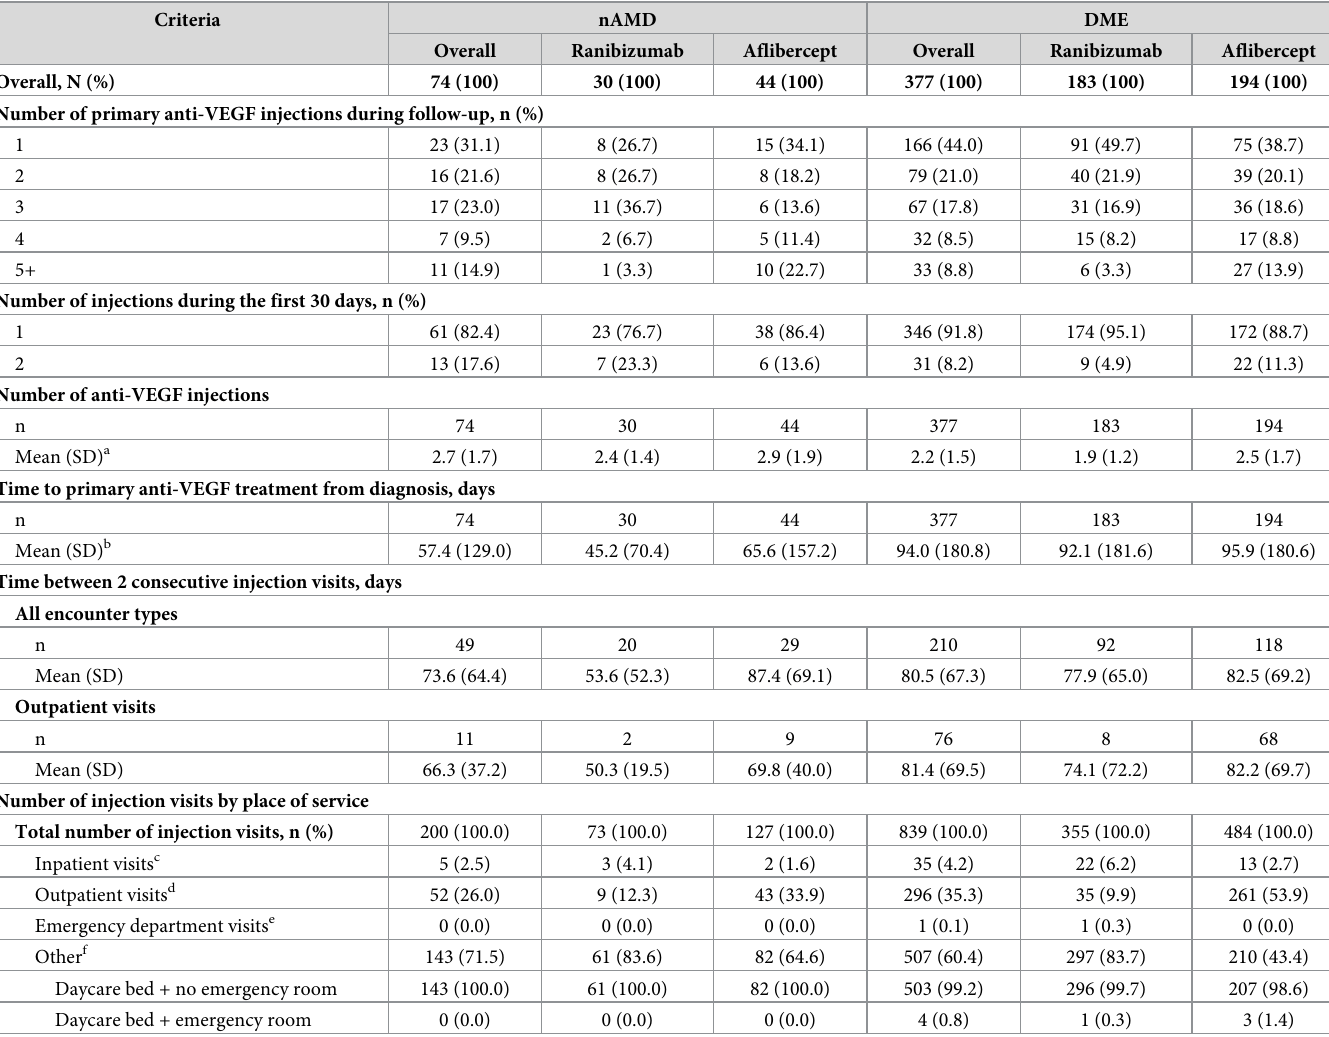
Table 3. Treatment pattern of primary anti-VEGF treatment during follow-up (Year 1).